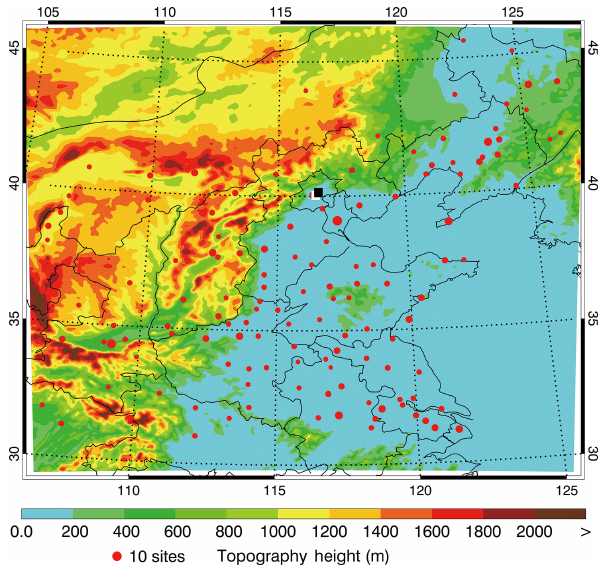
Figure 1. WRF-Chem simulation domain with topography height. The red filled circles show the locations of the cities with ambient air quality monitoring sites, and the size of the circles represents the number of sites in each city. The white and black filled rectan- gles denote the weather station and the NCNST observation site in